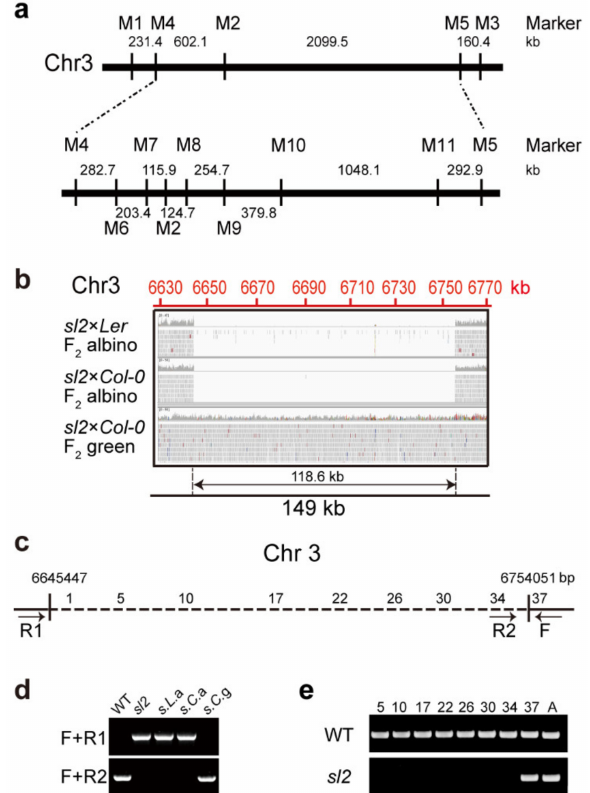
Figure 2. Isolation and mapping for albino cotyledon locus. ( a ) Schematic representing the map-based cloning of sl2 mutants; M1-M11 are molecular markers for map-based cloning; ( b ) Bulked segregant analysis of sl2 mutants; ( c ) Schematic diagram of genes in 118.6 kb deletion region; arrows indicate the primers used in ( d ). 1, 5, 10, 17, 22, 26, 30, 34, and 37 are the serial numbers of genes in the deletion region; ( d ) PCR analysis of genomic DNA from the WT and sl2 mutants showed a 118.6 kb deletion in the mutant. Annotation of the di ff erent samples: s.L.a, sl2 × Ler F 2 albino seedlings; s.C.a, sl2 × Col-0 F 2 albino seedlings; s.C.g, sl2 × Col-0 F 2 green seedlings; ( e ) The expression analysis of the genes (5- AT3G19220 , 10- AT3G19270 , 17- AT3G19300 , 22- AT3G19340 , 26- AT3G19380 , 30- AT3G19420 , 34- AT3G19460 , 37- AT3G19490 ) by RT-PCR. A, actin 2. All experiments were performed for two biological replicates and three technical